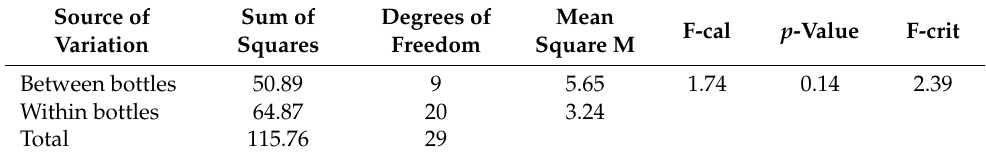
Table 3. One-way analysis of variance for the homogeneity study of the H 2 SiF 6 mass fraction.